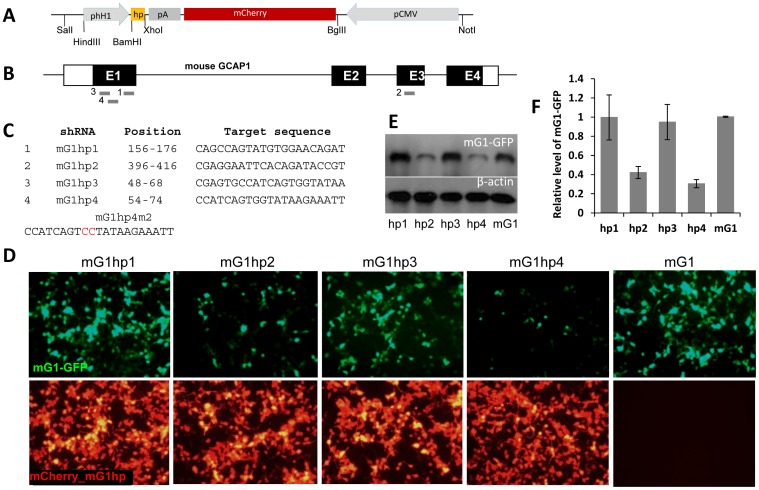
Knockdown of mouse GCAP1 in vitro by shRNAs.Schematic (A) shows shRNA expression construct that contains a 68-bp shRNA cassette driven by the human H1 promoter, and a CMV promoter-driven mCherry reporter gene. B. Schematic of the mouse GCAP1 gene and four candidate anti-mGCAP1 shRNAs, mG1hp1-4, each targeting a different exomic location. C. Targeting sequences of mG1hp1-4 and their positions within the GCAP1 gene. mG1hp4m2 is a mismatched control of mG1hp4 in which the central GG was replaced by CC (red). D. Knockdown efficiencies of anti-mGCAP1 shRNAs as determined by fluorescence microscopy of HEK293 cells 48 hr after cotransfection with mGCAP1-GFP and each anti-mGCAP1 shRNA, mG1hp1-4. Top row, GFP signal is diminished in cultures transfected with mG1hp2 and mG1hp4, indicating knockdown of mGCAP1 protein. Bottom row, mCherry reporter co-expression of mG1hp1-4 reveals comparable transfection efficiencies among the cultures. In the bottom far right panel, culture “mG1” was transfected with mGCAP1-GFP plasmids only as a non-knockdown control. E. Western blot analysis of transfected cell lysates at 50 hr post-transfection. mGCAP1-GFP was detected by anti-GCAP1 antibody, UW101, with β-actin immunostaining as the endogenous loading control. F. Relative levels of mGCAP1-GFP expression in the 50 hr transfected cultures were quantified by immunoblot band intensities and normalized against β-actin. The relative level of mG1-GFP in each cotransfected cell sample was averaged from three tests, representing the knockdown efficiency of each shRNA at different concentrations. Knockdown was most pronounced by transfection with mG1hp4, showing ∼70% decrease compared to mG1 non-knockdown control.